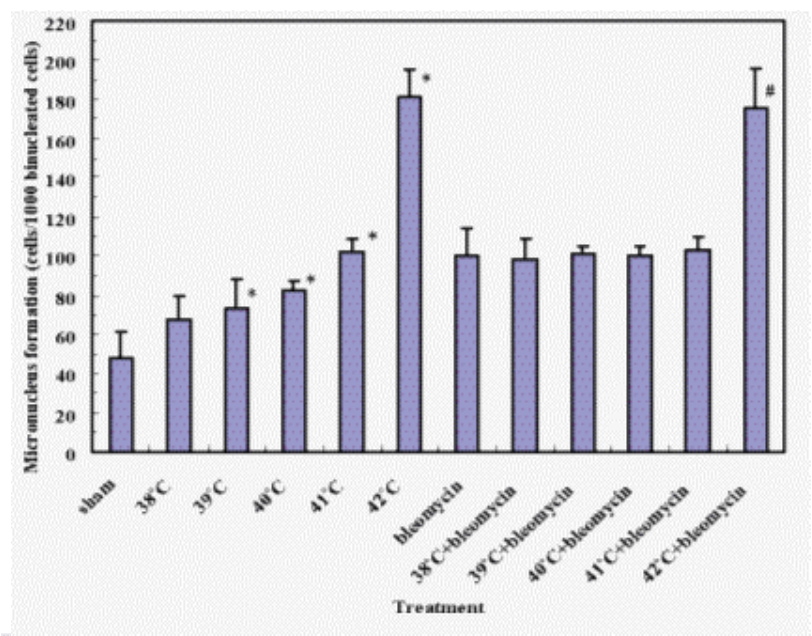
FIGURE 8. The effect of temperature on MN formation. The columns represent means and the bars show standard deviations, based on three experiments. An asterisk indicates a statistically significant difference between heat treatment alone and combined treatment with heat and bleomycin ( p < 0.01). A sharp indicates a statistically significant difference between treatment with bleomycin alone and combined treatment with heat and bleomycin ( p <